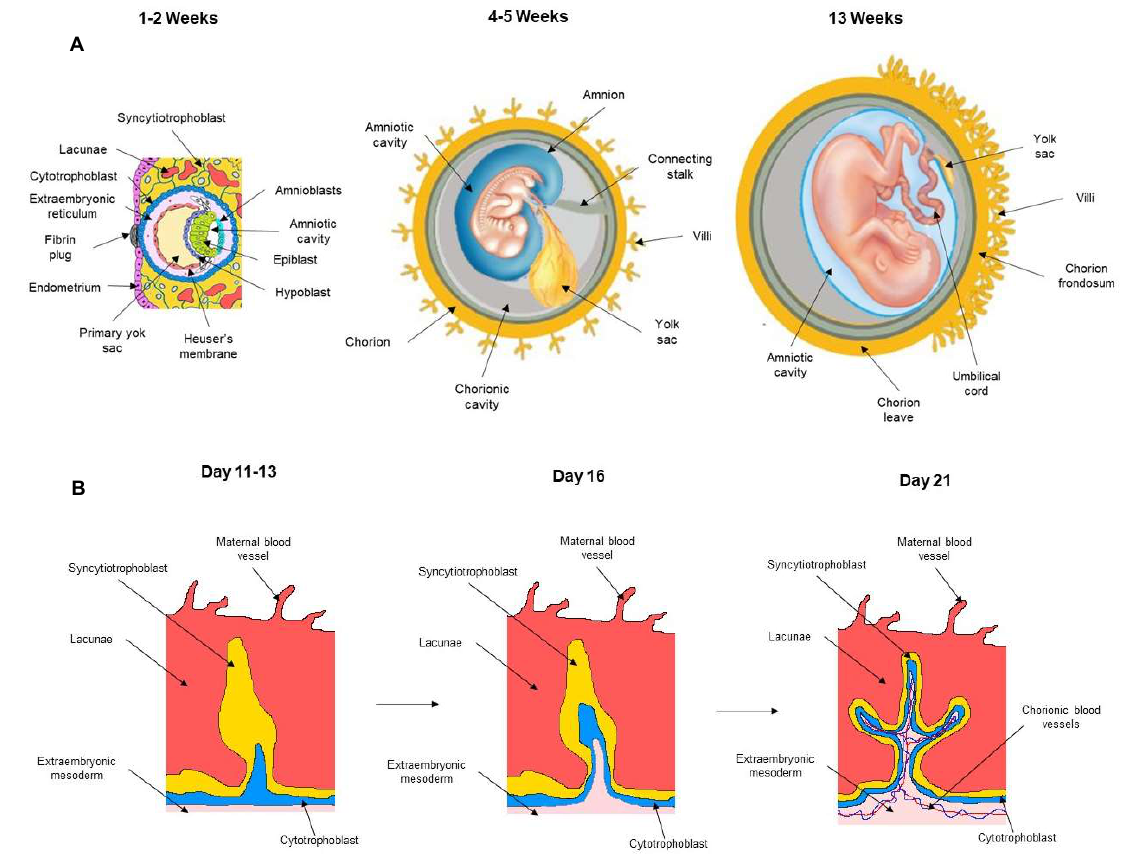
Figure 1. Uteroplacental circulation and fetal annex formation. ( A ) Development of embryonic and fetal annexes. ( B ) Development of chorionic villi. The scheme represents the formation of the primary, secondary, and tertiary villi .